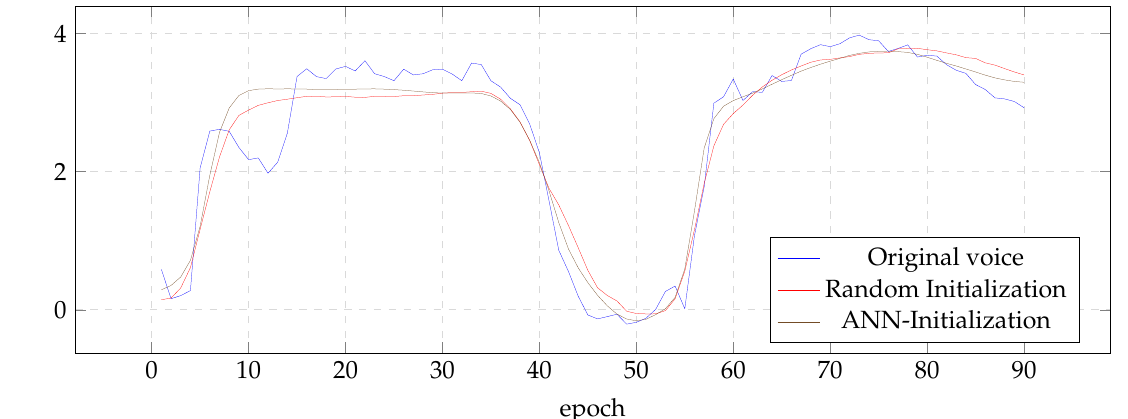
Figure 6. First MFCC for the BDL voice.